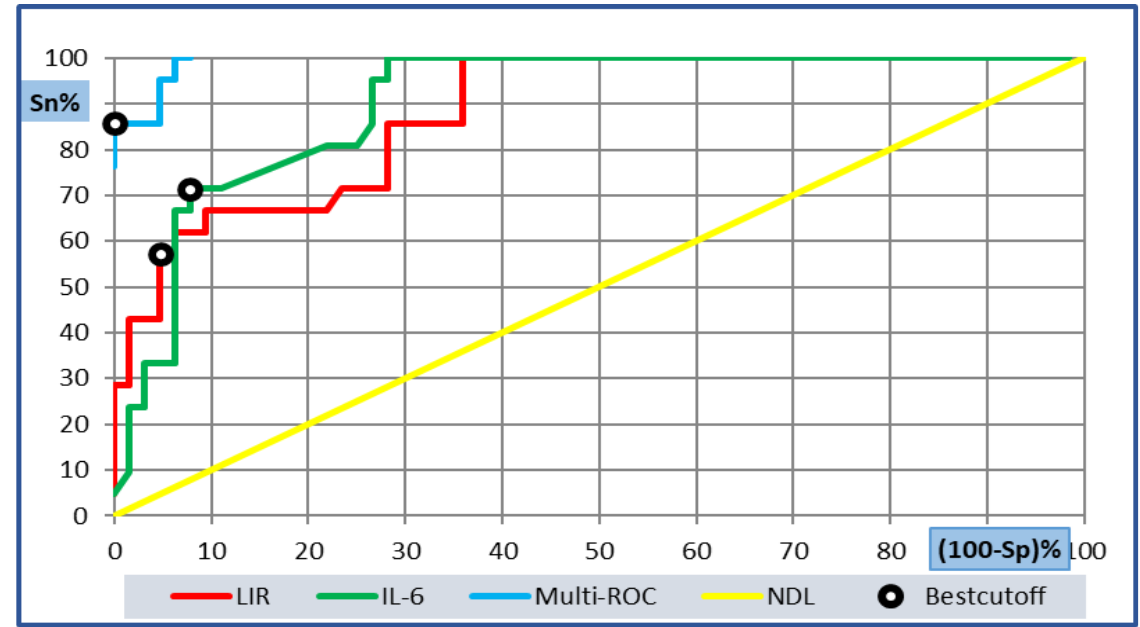
Figure 2. Diagnostic performance of L/IL-6 (AUC: 0.866; 95CI: 0.762-0.970); IL-6(AUC: 0.888; 95CI: 0.819- 0.957), and their combination (AUC: 0.946) for discriminating survivors from non-survivors in